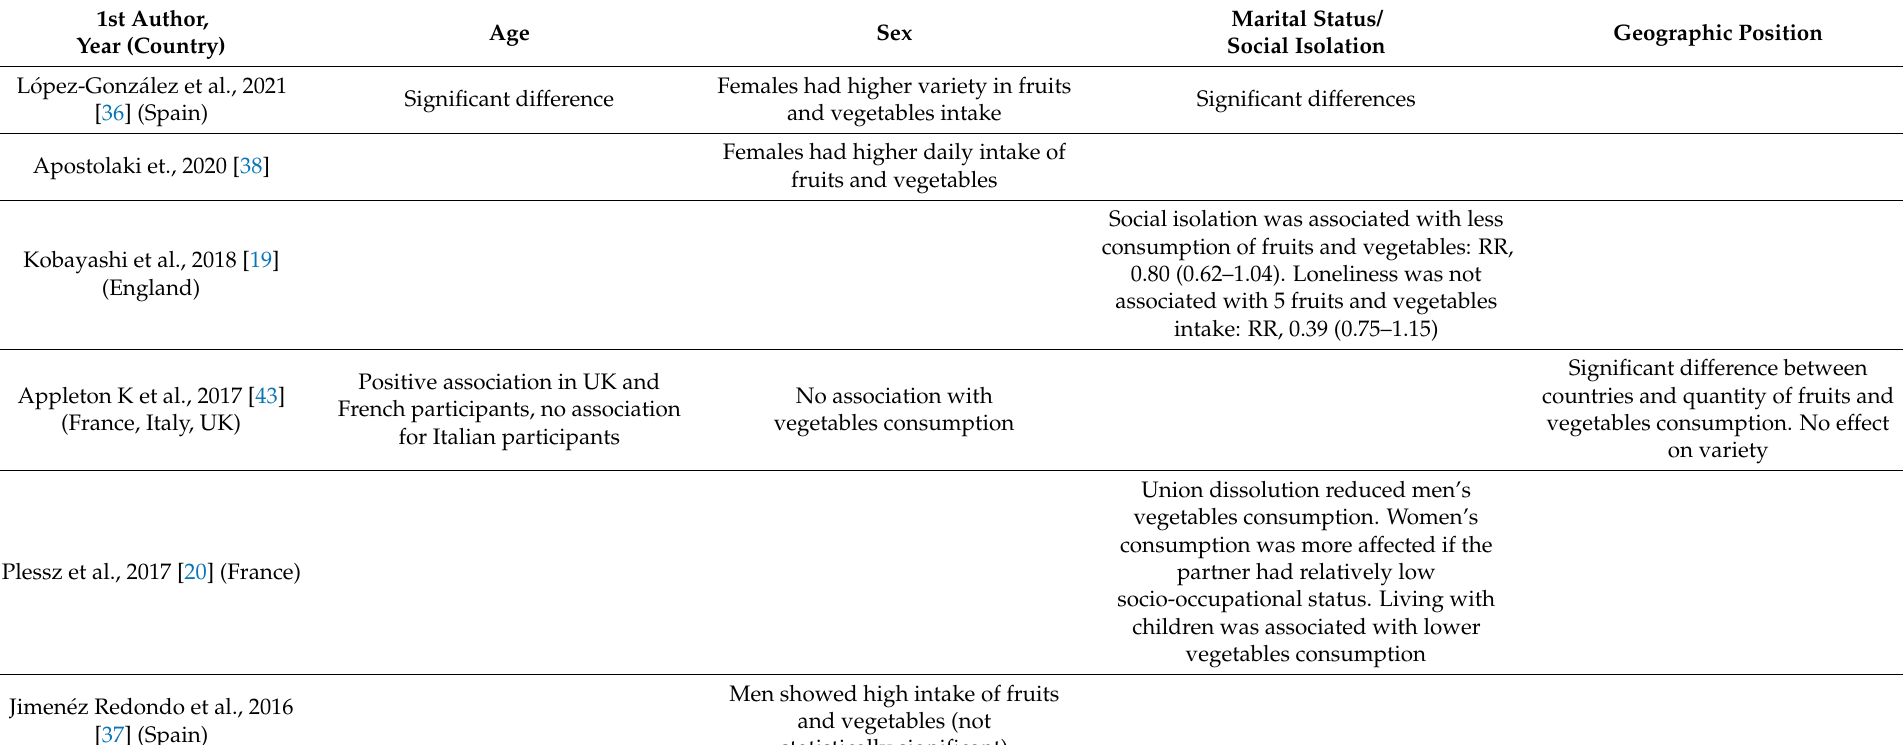
Table 4. Association between demographic determinants and fruits and vegetables